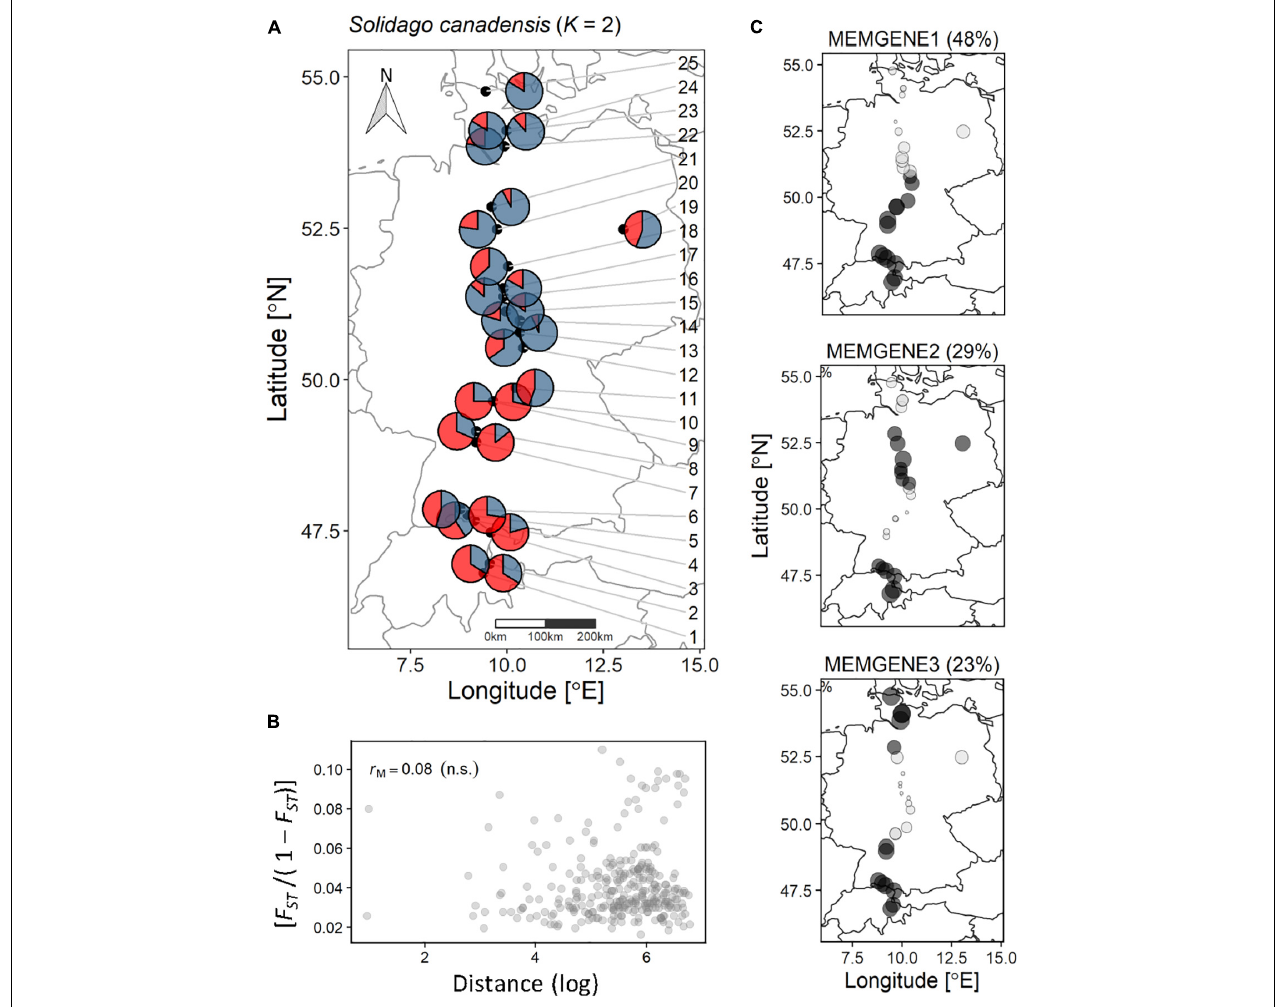
FIGURE 1 | Genetic structuring and spatial genetic neighborhood of the 25 sampled populations of S. canadensis along the latitudinal gradient. (A) Pie charts per population displaying the average probability per cluster ( K – 2). The population IDs are connected with arrows pointing to their location. (B) Standardized pairwise genetic diversity [ F ST /(1 - F ST )] vs. the pairwise log-distance between each population analyzed withe the Mantel test for isolation-by-distance. r M , Mantel statistic; n.s. , not significant. (C) The percentage of variation in spatial genetic autocorrelation axes (MEMGENE1, MEMGENE2, MEMGENE3) explained from Moran’s eigenvector maps. Dark gray circles denote positive values and light gray circles denote negative values. Circles of similar size and shade denote shared latent genetic